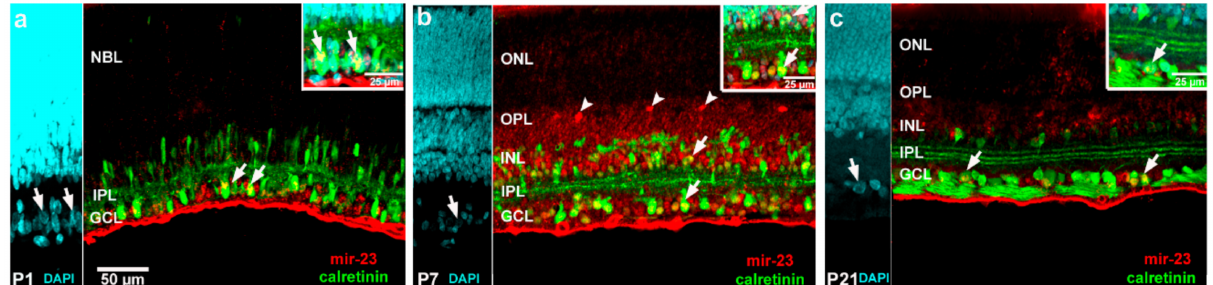
Figure 4. Representative images of miR-23 (red: TSA Cy 3) co-detection with calretinin (green: Alexa Fluor-488) at the indicated postnatal days (miR-23 with calretinin: ( a ) P1; ( b ) P7; ( c ) P21). Inserted images demonstrate the overlap of ISH-dual IHC. Arrows indicated co-localizations in cells in the GCL and the INL, while non-colocalized cells (horizontal cells) were demonstrated by arrowheads. Scale bar in retina sections: 50 µ m (both DAPI and IHC), in inserts: 25 µ m. GCL—ganglion cell layer; IPL—inner plexiform layer; NBL—neuro blast layer; INL—inner nuclear layer; OPL—outer plexiform layer; ONL—outer nuclear